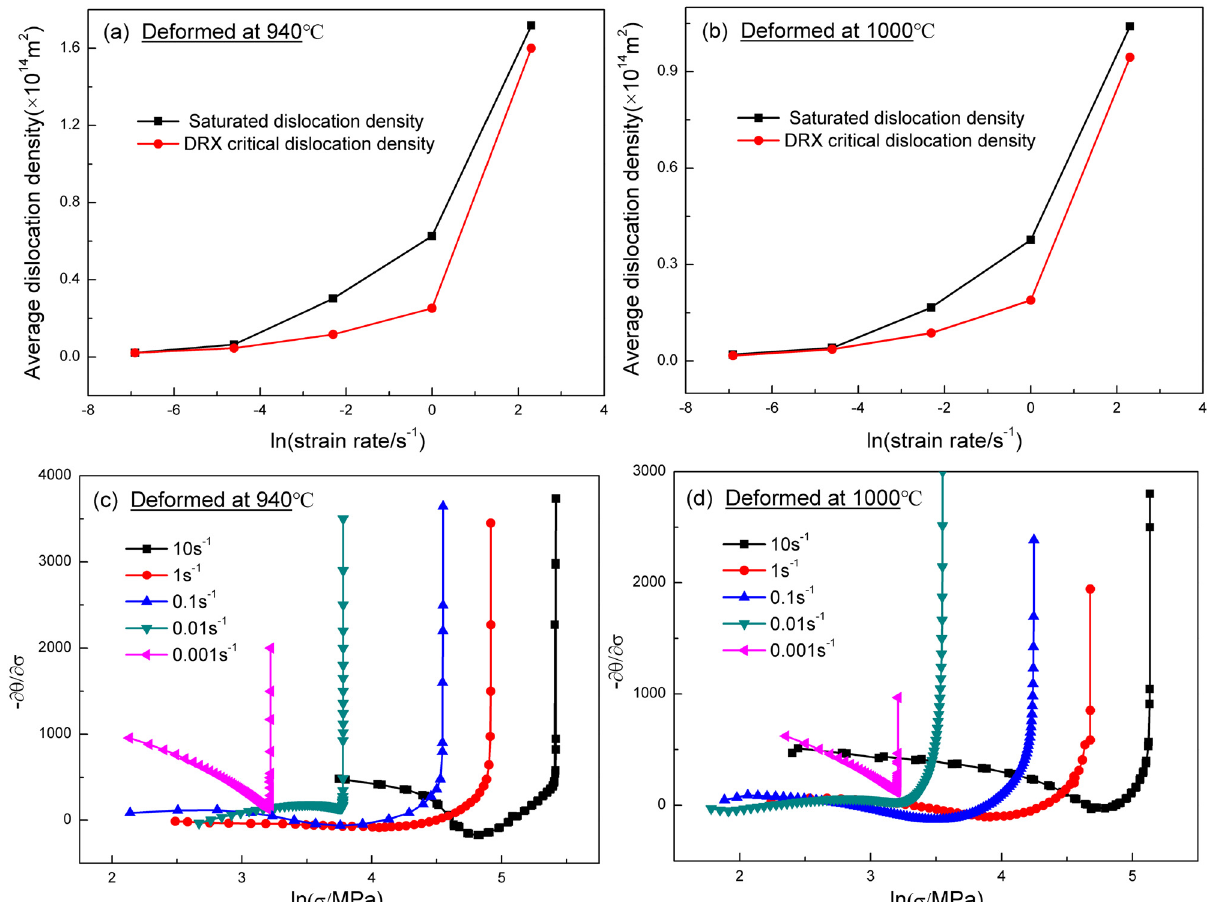
Figure 6: Comparisons between ρ sat and ρ c , and veri fi cation of the dynamic softening behavior through Poliak – Jonas criterion under di ff erent deformation conditions of ( a and c ) 940°C and ( b and d )